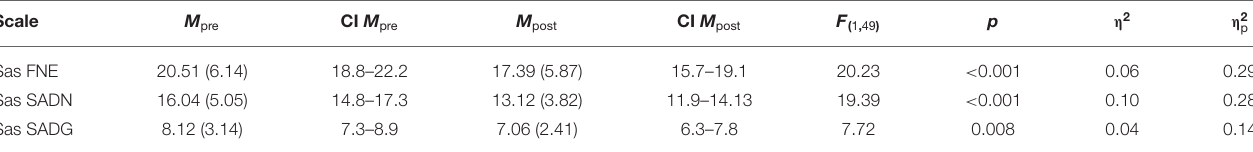
TABLE 2 | Statistics for SAS subscales before and after treatment.